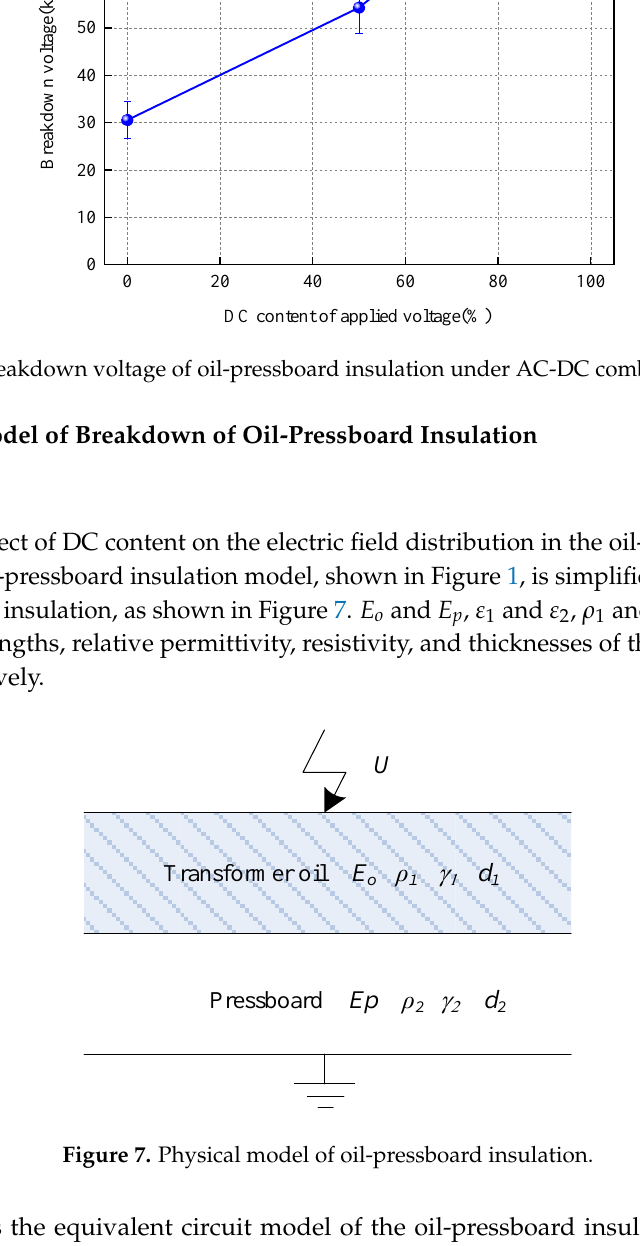
Figure 7. Physical model of oil-pressboard insulation.